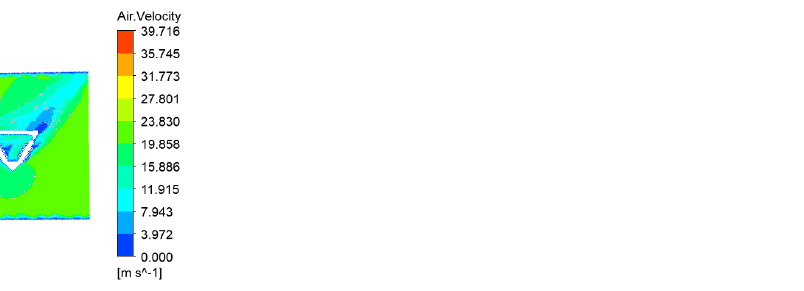
Figure 36. Cloud map of velocity distribution in the plane with 45 ◦ wind elevation angle.